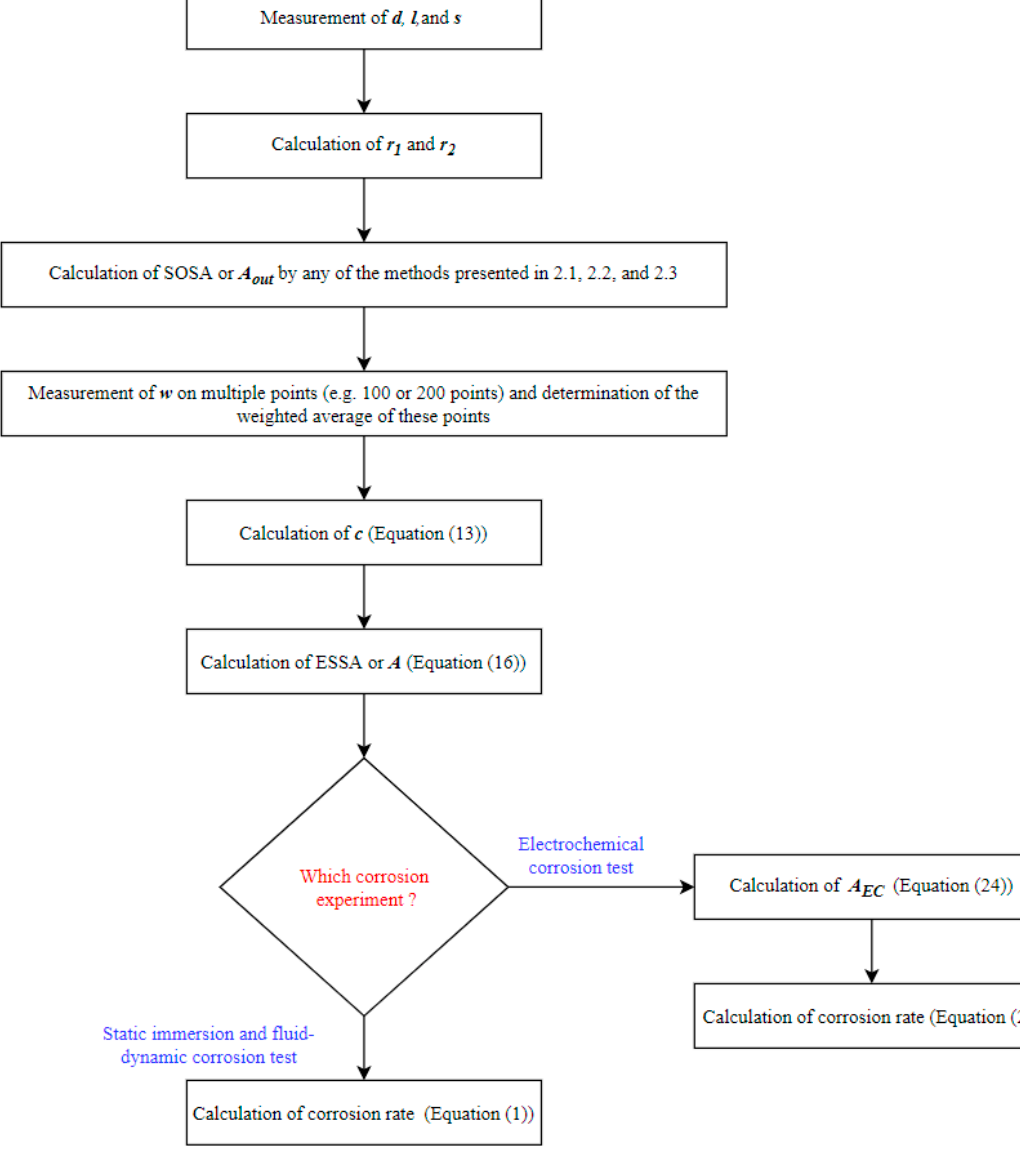
Figure 4. Schematic diagram of the algorithm to apply the surface area model for corrosion rate calculation.